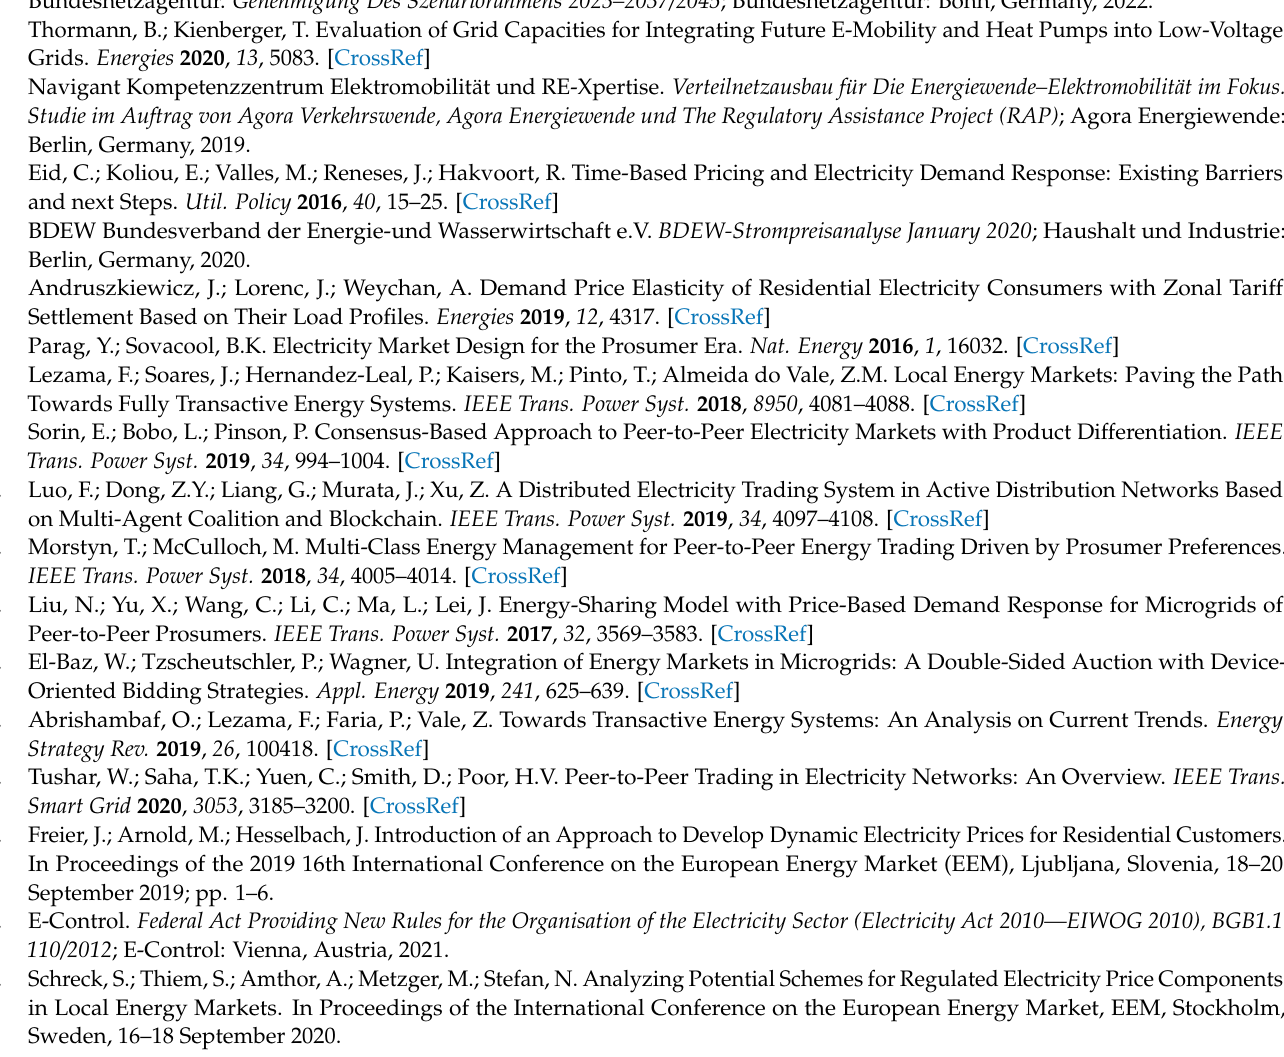
Figure A4. Heatmap of the electric demand (positive values) and feed-in (negative values) for the power fee scenario, the scenario year 2035 and the rural grid.